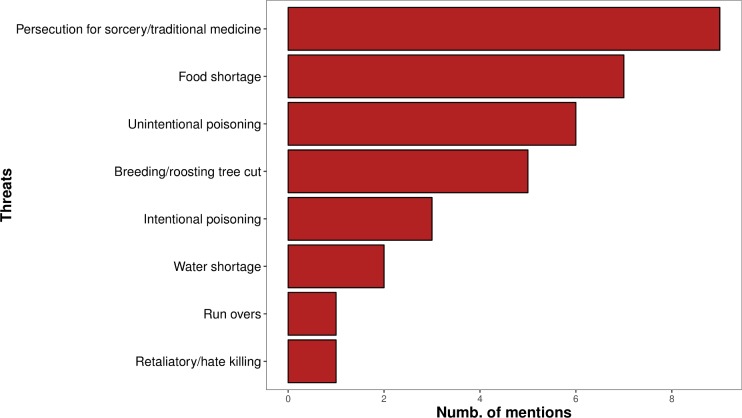
Threat analysis exercise.Threat analysis exercise, showing the number of mentions of each threat. In each interview, respondents could mention more than one threat, thus total exceeds sample size/number of interviews (n = 23).